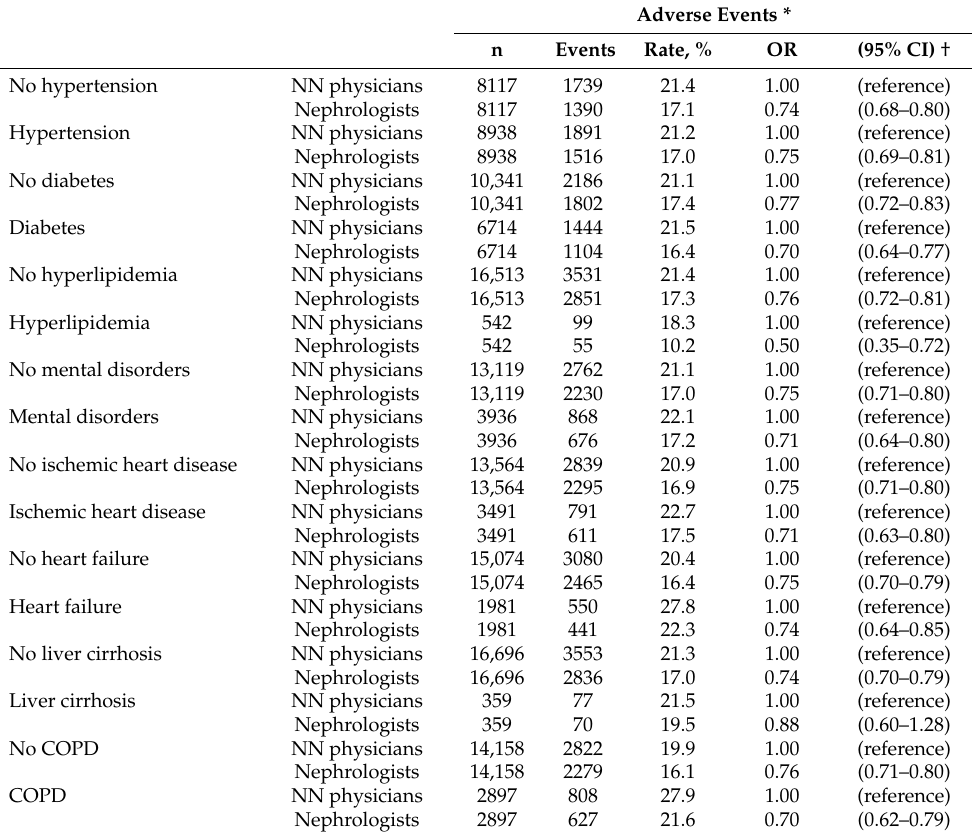
Table 4. The stratified analysis by specific medical conditions for the association between physician specialty and adverse events after the admission due to kidney